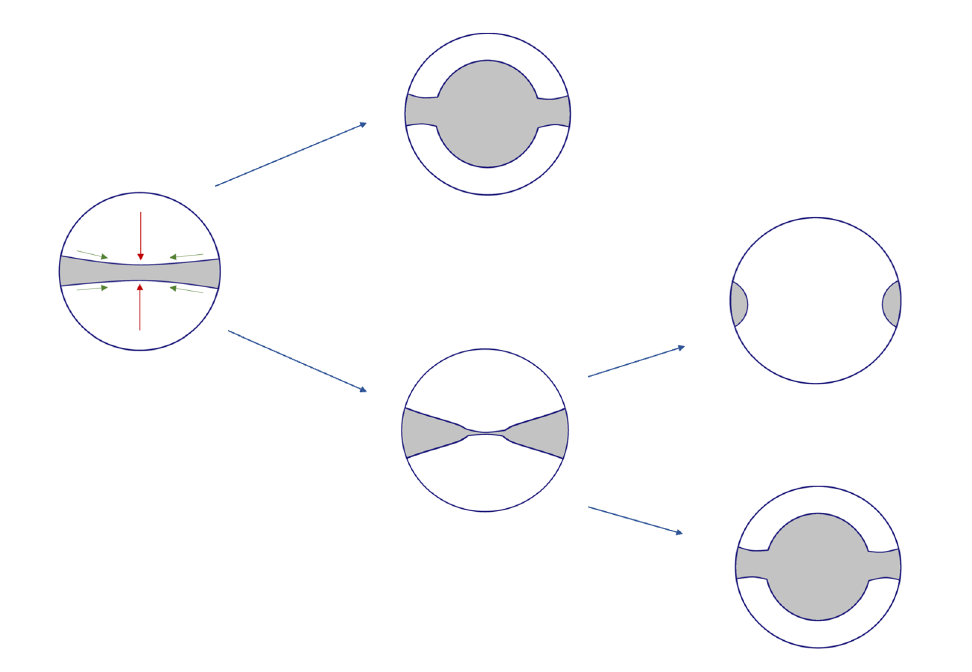
Figure 1 . Representatives of three scenarios for the evolution of unstable black strings in AdS. The two competing effects, shown in the left diagram, are the pinching near the center (red arrows) and the inflow of generators from the boundary, dubbed black tsunami (green arrows). In the first scenario (top), the tsunami dominates and the system is directly driven to a fat black funnel. In other scenarios, the horizon pinches, leading to a naked singularity that splits the horizon into twin black droplets without triggering a tsunami (middle); or the pinch forms, but is later covered by a black tsunami, ending again at a fat funnel (bottom). Other possible final configurations that are not shown include metastable non-uniform strings, or central black holes between